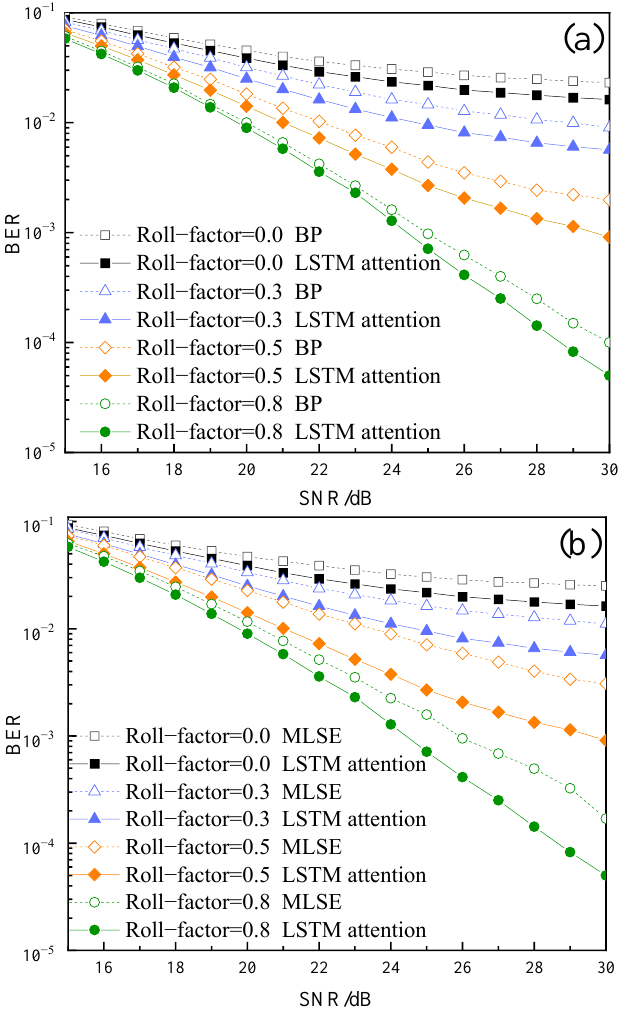
Figure 7. Relationship between BER and roll factor: ( a ) LSTM attention and BP decoding algorithms; ( b ) LSTM attention and MLSE decoding algorithms.